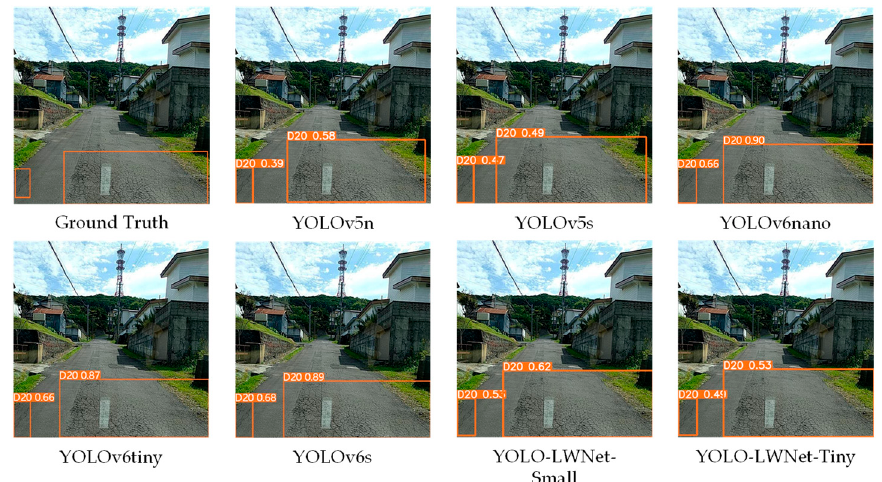
Figure 14. Comparison of the detection of transverse cracks (D10).